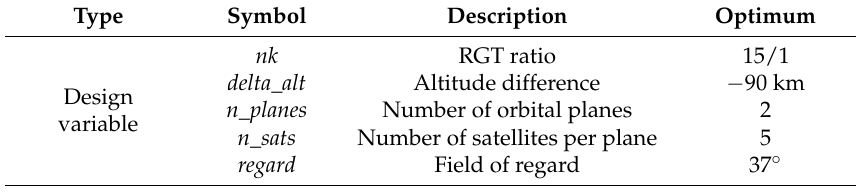
Table 19. SD optimal solution (2 planes).